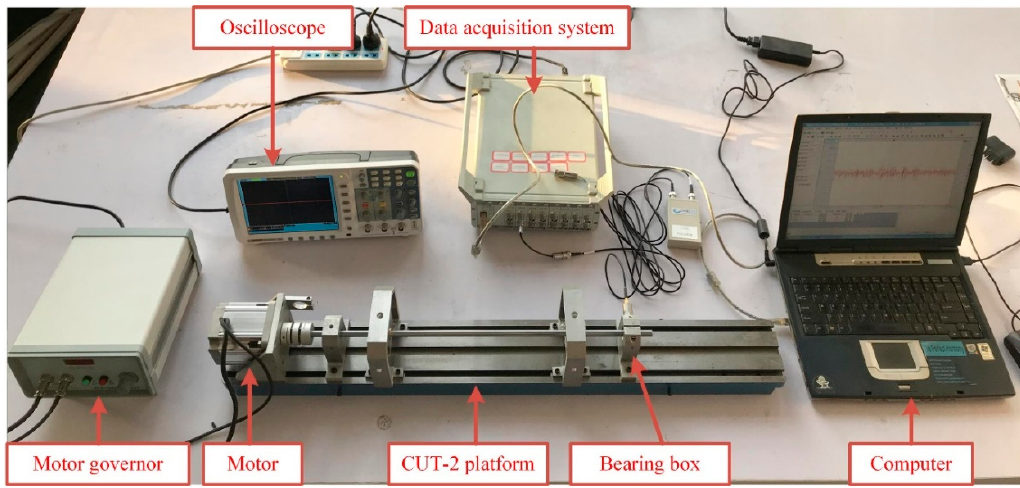
Figure 11. CUT-2 bearing experimental platform.